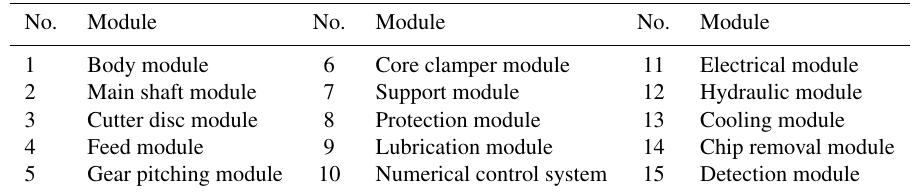
Table 1. Modules of the special machine tool for VH-CATT cylindrical gears.